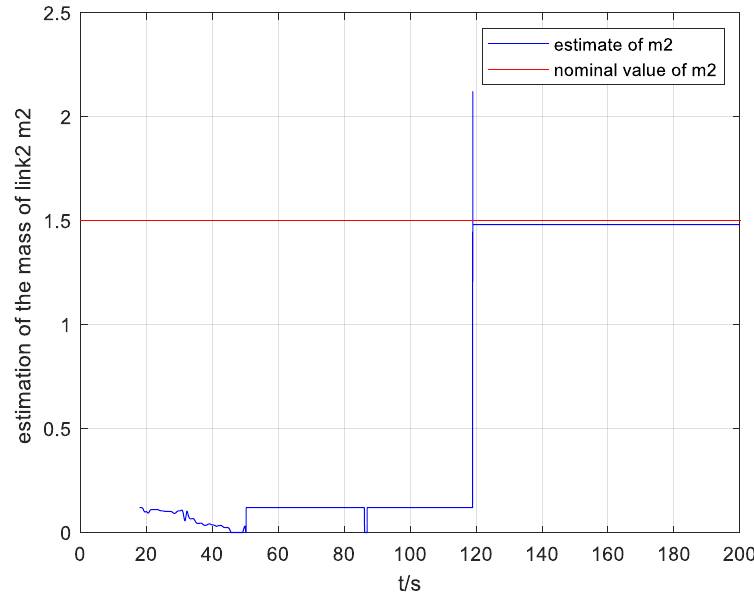
Figure 4. Estimation of link 1′s mass 𝑚 1 .